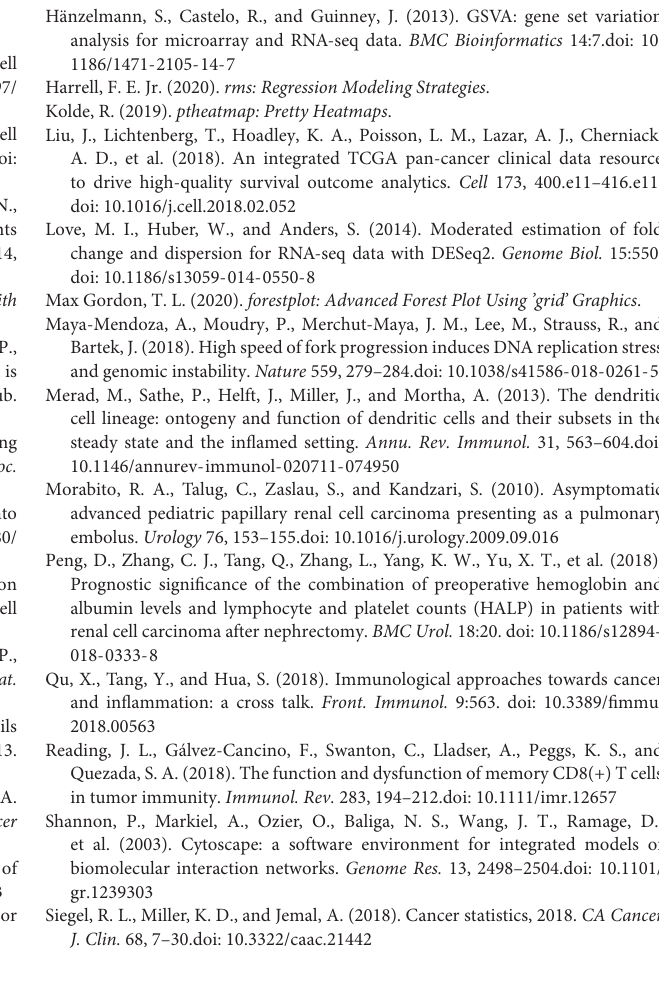
Supplementary Figure 1 | Differential non-coding RNA expression profiles in PRCC patients stratified by TICRR levels. Expression profiles of miRNAs (A,C) and lncRNAs (B,D) in two groups are presented by volcano plots (A,B) and heatmaps (C,D) . Supplementary Figure 2 | Protein-protein interaction networks of DEGs in PRCC patients with high- and low- TICRR expression levels. Based on the 691 differentially expressed mRNAs between high- and low- TICRR expression groups, we analyzed interactions using the STRING database, where the interaction threshold was set as 0.4. The line represents protein-protein interactions. The darker the filling color, the more mRNA interactions. Supplementary Figure 3 | Mean decrease Gini plot for important indexes associated with overall survival in PRCC patients. The random forest model was used to rank significant indexes, enrolling age, sex, smoking history, serum calcium level, hemoglobin level, TMN stage, clinical stage, and TICRR expression. Supplementary Table 1 | Top 20 clusters in pathway and process enrichment analysis of DEGs in PRCC patients with distinct TICRR